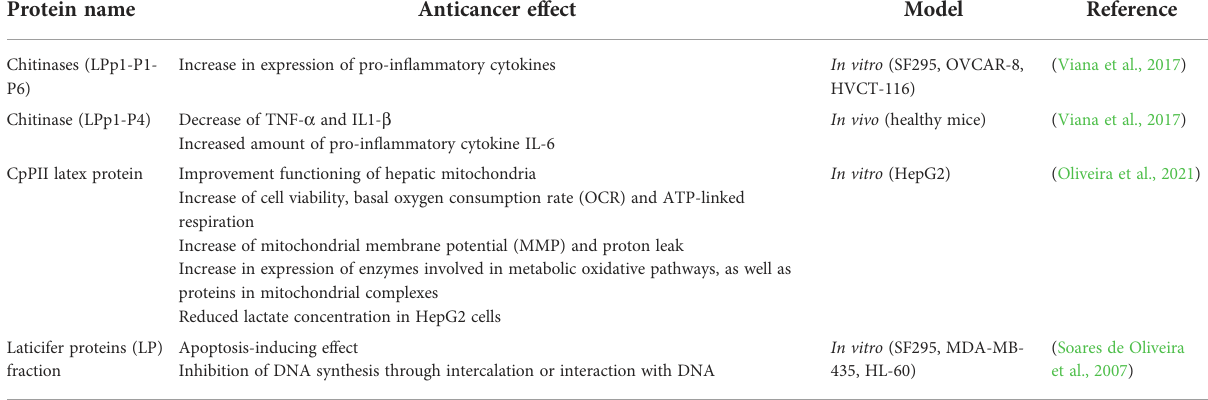
TABLE 2 Potential anticancer activity of Calotropis procera latex proteins in in vitro and in vivo